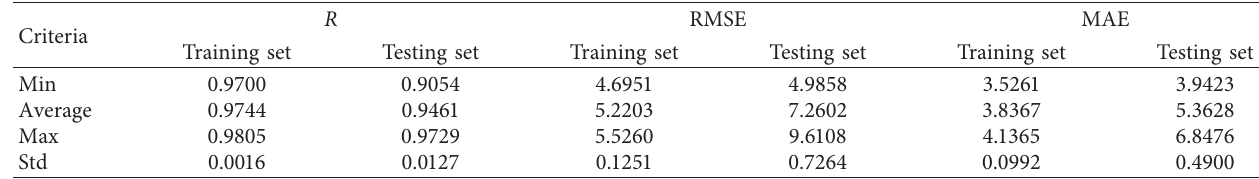
Table 2: Summary of different quality assessment criteria over 500 simulations with the best RF architecture.